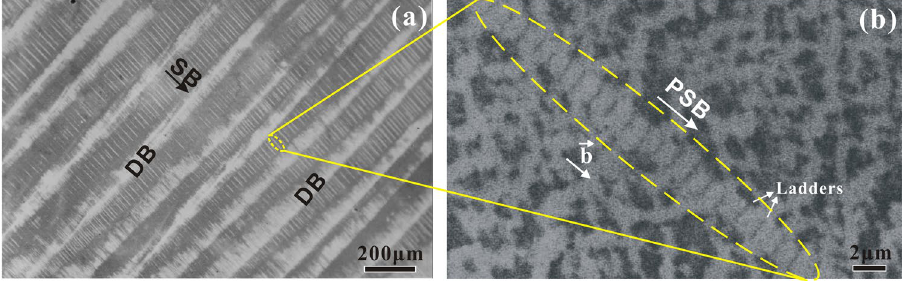
Figure 3. Surface slip morphology and corresponding dislocation patterns of the fatigued Cu single crystal. ( a ) SBs and DBII; ( b )